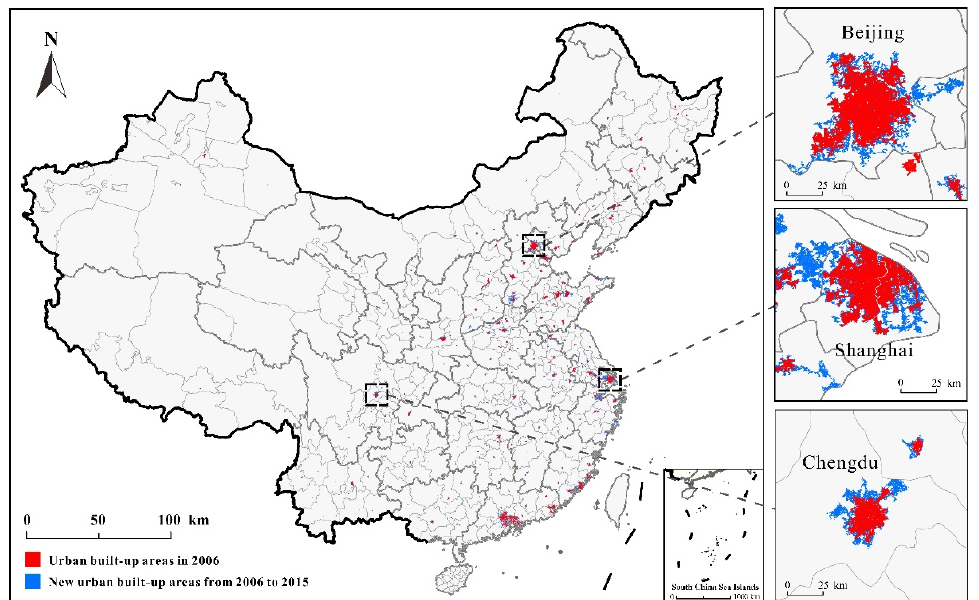
Figure 1. Research area.